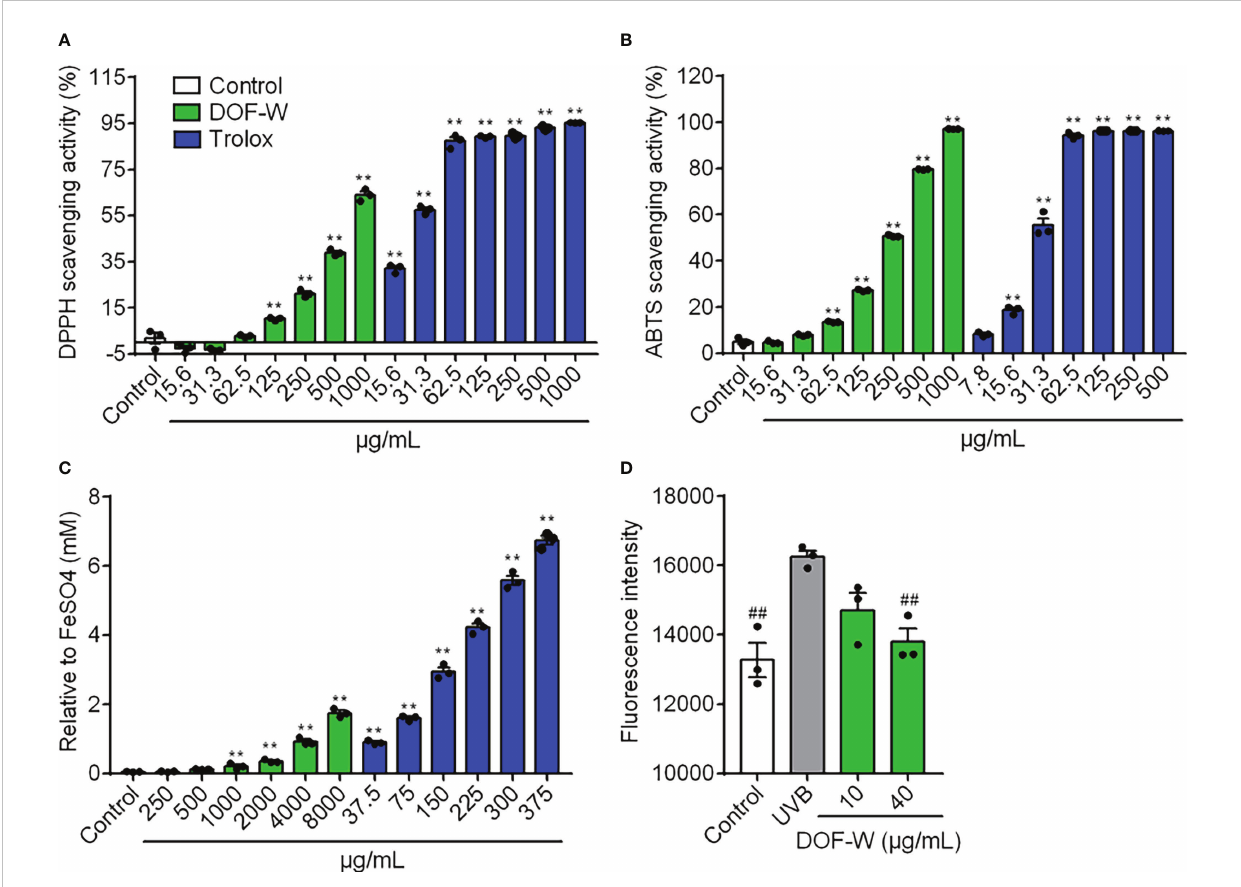
FIGURE 2 Antioxidant potency of DOF extracts. DPPH scavenging activity (A) , ABTS scavenging activity (B) , FRAP value (C) , and intracellular ROS level (D) of DOF-W. Compared with the control, ** p< 0.01. Compared with the UVB model, ## p<